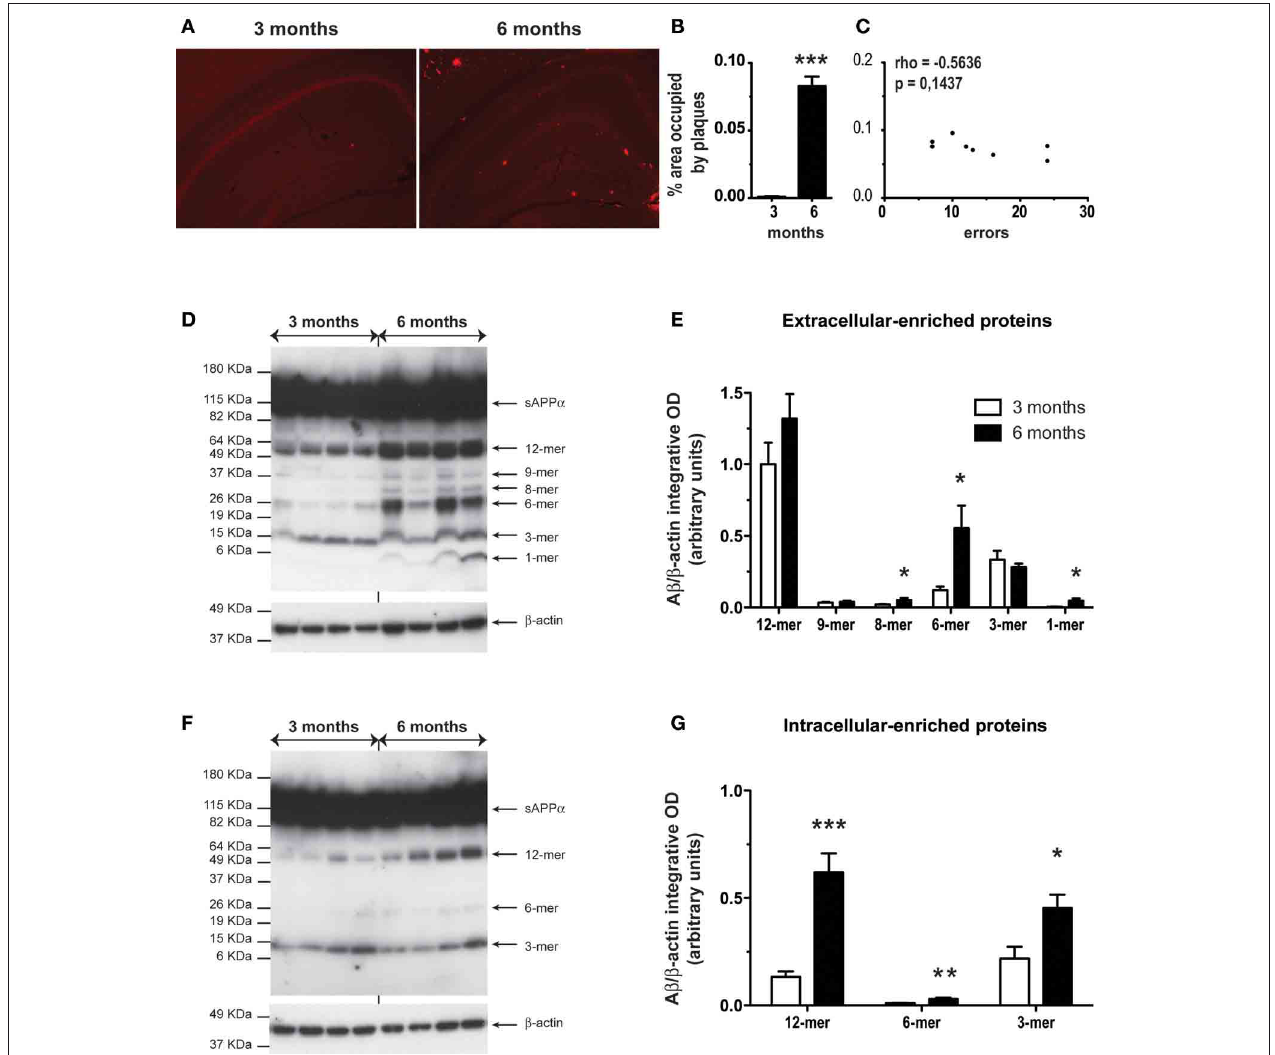
FIGURE 1 | Six-month-old APP Swe /PS1 mice had higher level of A β soluble oligomers in the hippocampus. Anti-A β immunoreactivity is depicted in hippocampus of APP Swe /PS1 at 3 and 6 months of age (A) . A detailed analysis of plaque quantification was performed to determine the percentage area occupied by plaques (B) of 3- and 6-month-old APP Swe /PS1. A β load was strongly increased at 6 months age in hippocampus. A correlation’s test revealed no significant correlation between spatial memory decline (water T-maze test) and the percentage area occupied by plaques at the age of mnesic deficit occurrence (6 months) (C) . Therefore, the hippocampus level of soluble A β was